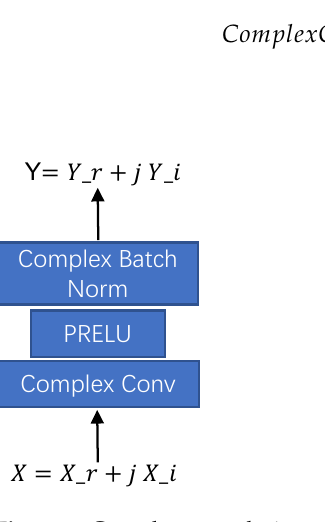
Figure 2. Complex convolution